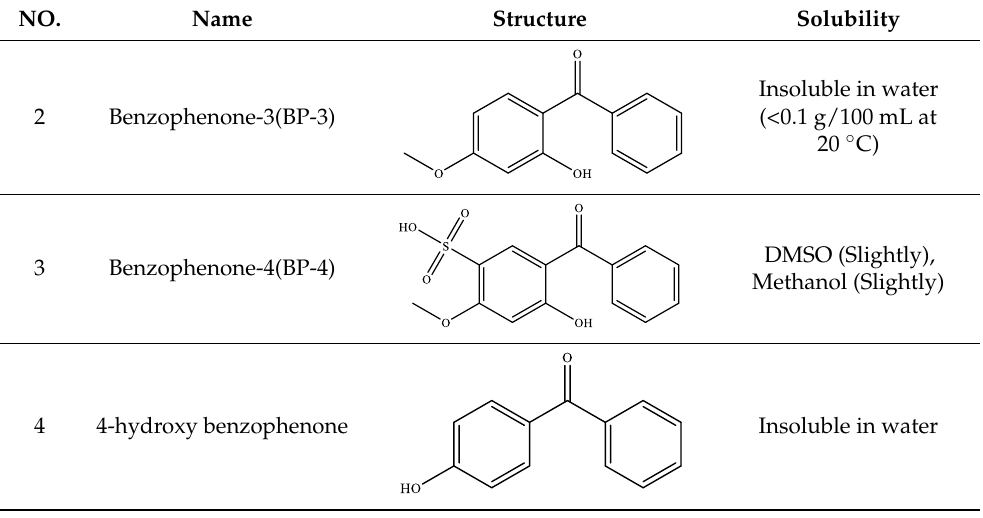
Table 1. The structure and solubility of Part BPs.